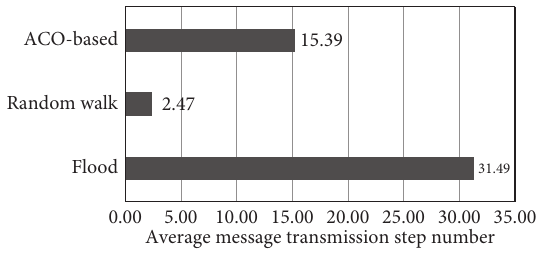
number0.00 Average message transmission step Fig. 5 Average message transfer step contrast (6) In the scalability test of the search algorithm, the number of network nodes is changed. Other variables are unchanged and carry out simulation experiments on the basis of the ant colony-